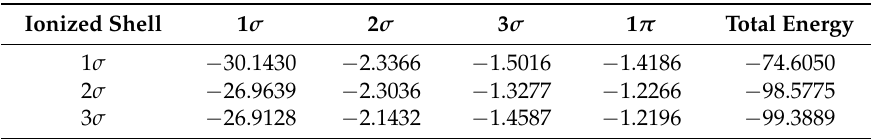
Table 3. One-electron energy MO and the total energy of the ionized states of the HF molecule and (in atomic